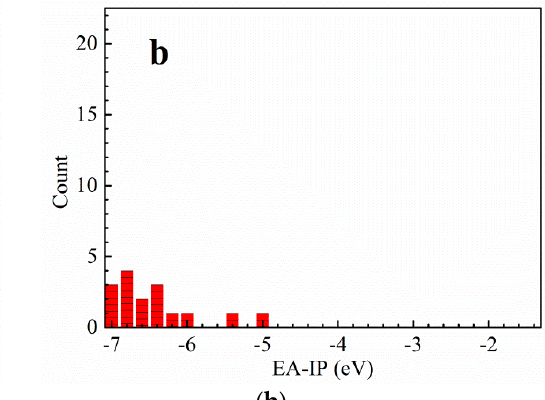
Figure 5. Structures of a series of cations in cyclo -N 5 − salts.